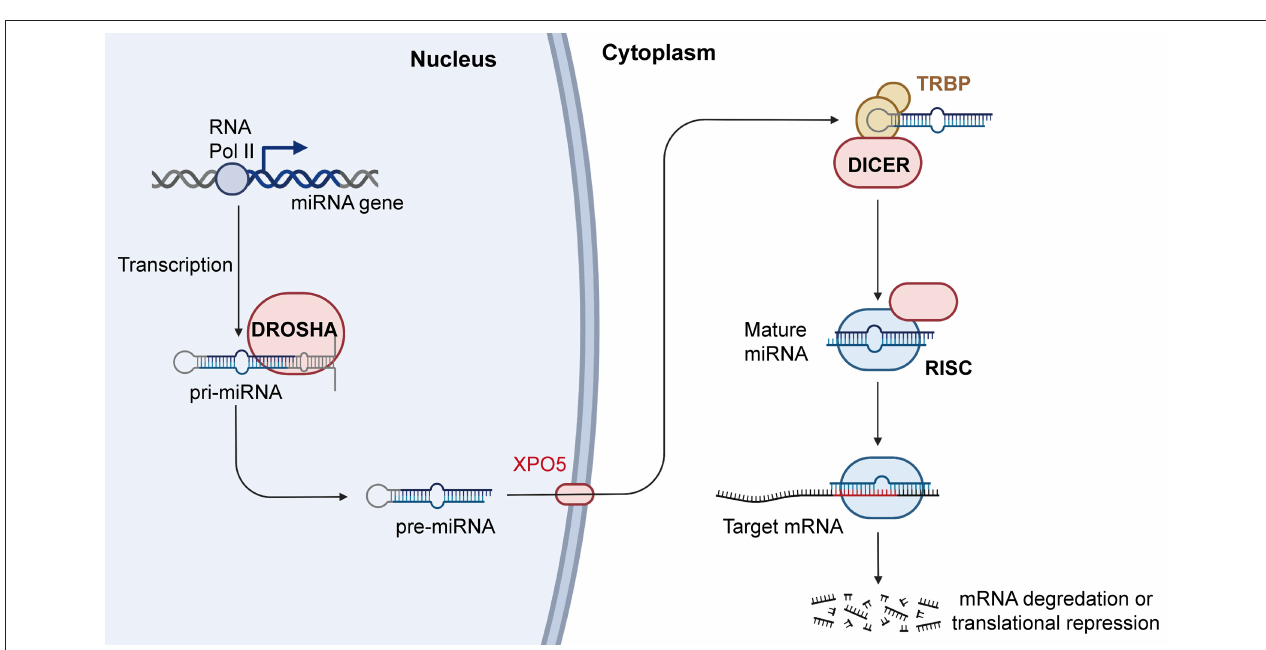
FIGURE 3 | Biogenesis and mechanism of miRNA. RNAPII transcribes miRNA genes into pri-miRNAs, and the pri-miRNAs are cleaved by Drosha into the pre-miRNAs. Pre-miRNAs are transferred from nucleus to cytoplasm with the help of XPO5, and Dicer can process the pre-miRNAs into mature miRNAs.